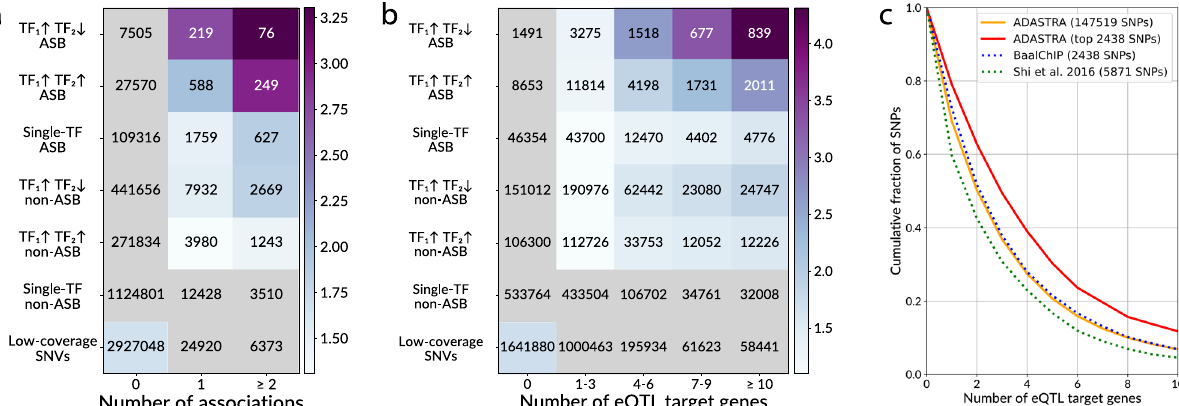
Fig. 5 ASBs are enriched with pathologic phenotype associations and eQTLs. a , b Enrichment of ASBs among phenotype-associated and eQTL SNVs. Y - axis denotes several exclusive groups of SNPs: TF1 ↑ TF2 ↓ , SNVs carrying both Ref- and Alt-ASBs of different TFs, i.e., where at least two TFs prefer to bind alternating alleles; TF1 ↑ TF2 ↑ , SNVs carrying ASBs for at least two TFs preferring to bind the same allele; single TF, SNVs with ASB of a single TF; low- covered SNVs that did not pass a total coverage threshold ≥ 20. Non-ASBs are SNVs with the TF-ASB FDR > 0.05. X -axis: a the number of unique (dbSNP ID, trait, database) triples for a given SNV considering four databases of SNP-phenotype associations (EBI, ClinVar, PheWAS, and BROAD autoimmune diseases fi ne-mapping catalog); b the number of eQTL target genes according to GTEx eQTL data. The coloring denotes the odds ratios of the one-tailed Fisher ’ s exact test for the enrichment of SNVs with associations for each group of ASBs (against all other SNVs in the table). The gray cells correspond to nonsigni fi cant enrichments with P > 0.05 after Bonferroni correction for the total number of cells. The values in the cells denote the numbers of SNVs. c The fraction of ASB SNPs from particular ASB collections ( Y -axis) coinciding with GTEx eQTLs passing a certain threshold for the number of target genes ( X -axis). Fourteen cell types overlapping between ADASTRA (solid orange line) and BaalChIP (dotted blue line) data have been considered: A549, GM12878, GM12891, GM12892, H1hESC, HL60, HeLa, HepG2, IMR90, K562, MCF10, MCF7, SKNSH, T47D. Data for HeLa and GM12878 cells were extracted from the Shi et al. collection (dotted green line). A subset of 2438 top-signi fi cant ADASTRA ASBs (the subset size equal to that of the BaalChIP set) is additionally shown to illustrate that these ASBs relatively more often coincide with potent eQTLs. SNP single-nucleotide polymorphism, SNV single- nucleotide variant, ASB allele-speci fi c binding, eQTL expression quantitative trait